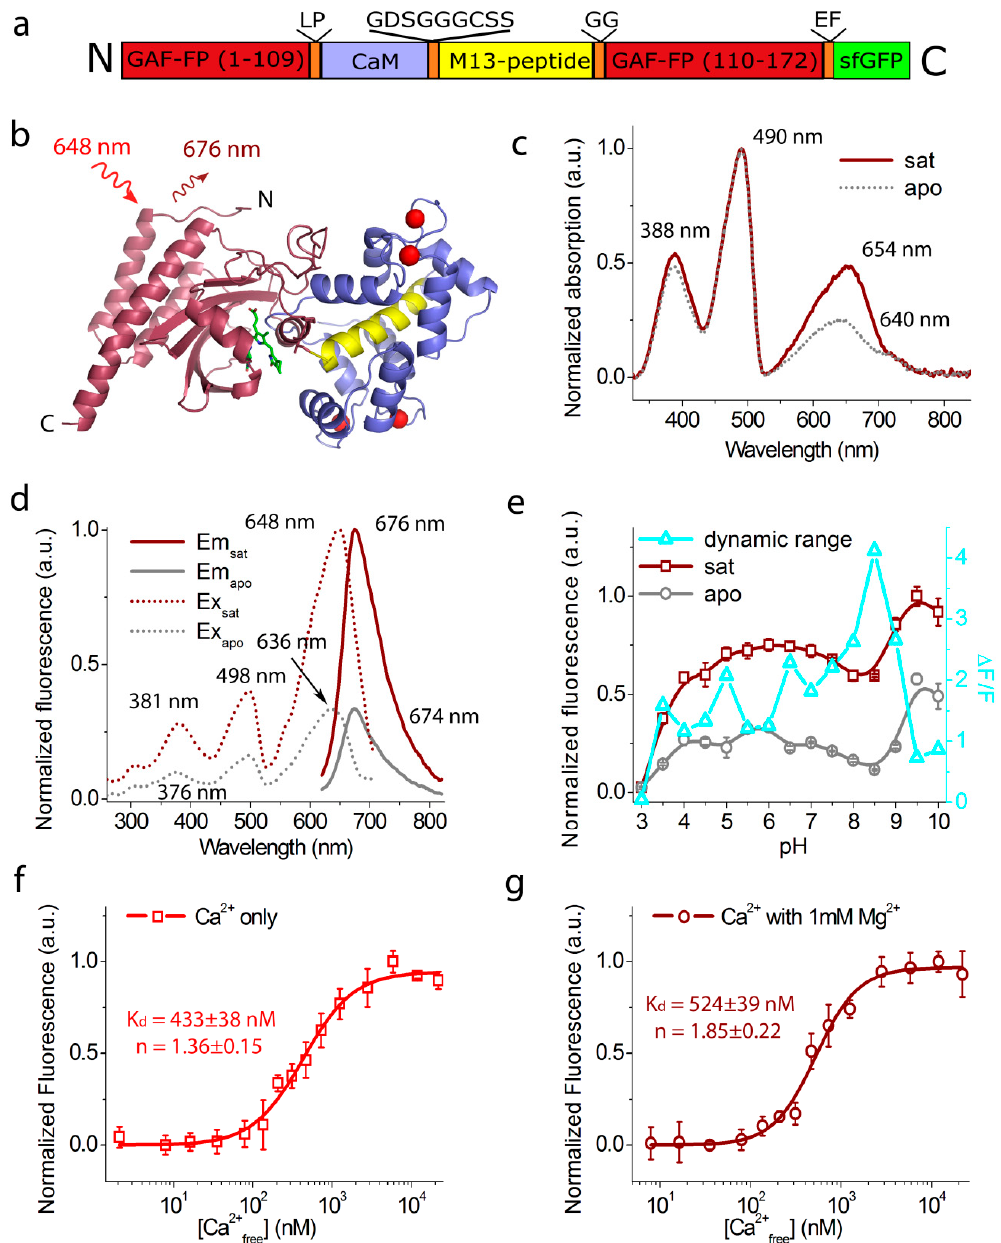
Figure2. In vitropropertiesofthepurifiedGAF-CaMP3–sfGFPindicator. ( a )Aschematicrepresentation Figure 2. In vitro properties of the purified GAF-CaMP3–sfGFP indicator. (a) A schematic of the GAF-CaMP3–sfGFP indicator. ( b ) Suggested structural organization of the GAF-CaMP3 indicator representation of the GAF-CaMP3–sfGFP indicator. (b) Suggested structural organization of the GAF- CaMP3 indicator based on the crystal structures of the GAF domain (PDB 3C2W) and CaM–M13 based on the crystal structures of the GAF domain (PDB 3C2W) and CaM–M13 peptide (PDB 6XW2). peptide (PDB 6XW2). The GAF domain, BV chromophore, CaM, M13 peptide, and calcium ions are The GAF domain, BV chromophore, CaM, M13 peptide, and calcium ions are highlighted in wine, green, highlighted in wine, green, cyan, yellow, and red, respectively. Excitation light and emission with cyan, yellow, and red, respectively. Excitation light and emission with maxima are shown by red and maxima are shown by red and wine arrows, respectively. (c) Absorption spectra for GAF-CaMP3– wine arrows, respectively. ( c ) Absorption spectra for GAF-CaMP3–sfGFP in Ca 2 + -bound and Ca 2 + -free sfGFP in Ca 2+ -bound and Ca 2+ -free states at pH 7.2. (d) Excitation and emission spectra for GAF- statesatpH7.2. ( d )ExcitationandemissionspectraforGAF-CaMP3–sfGFPinCa 2 + -boundandCa 2 + -free CaMP3–sfGFP in Ca 2+ -bound and Ca 2+ -free states at pH 7.2. (e) Fluorescence intensity for GAF- states at pH 7.2. ( e ) Fluorescence intensity for GAF-CaMP3–sfGFP in Ca 2 + -bound and Ca 2 + -free states CaMP3–sfGFP in Ca 2+ -bound and Ca 2+ -free states and dynamic range as a function of pH. (f,g) Ca 2+ and dynamic range as a function of pH. ( f , g ) Ca 2 + titration curves for GAF-CaMP3–sfGFP in the absence titration curves for GAF-CaMP3–sfGFP in the absence (f) and in the presence (g) of 1 mM MgCl 2 at ( f ) and in the presence ( g ) of 1 mM MgCl 2 at pH 7.2. The experimental data were fitted by the Hill pH 7.2. The experimental data were fitted by the Hill equation. (e–g) Three replicates were averaged equation. ( e–g ) Three replicates were averaged for analysis. Error bars represent the standard for analysis. Error bars represent the standard deviation.